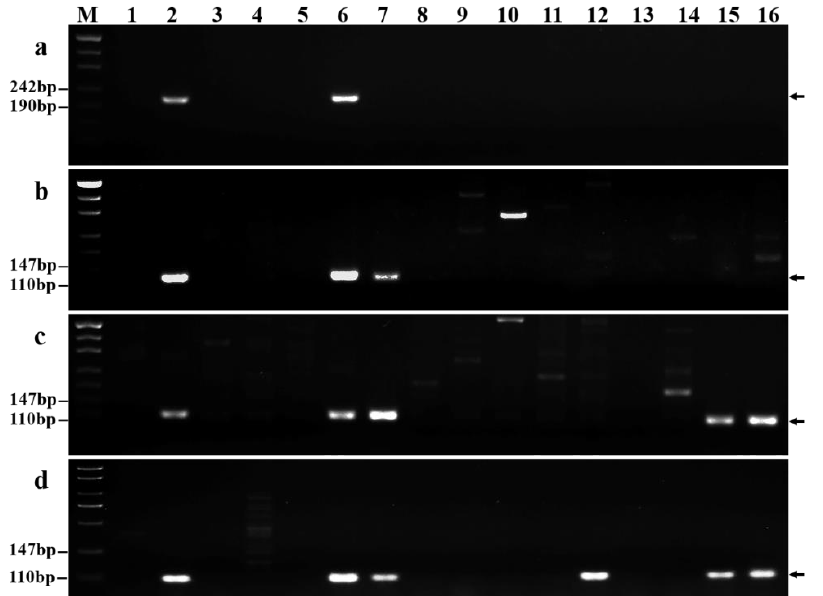
Figure 7. Specificity and stability of P. huashanica 7Ns chromosome-specific markers in other wheat- related species. ( a ) GPH7Ns-155; ( b ) GPH7Ns-300; ( c ) GPH7Ns-523; and ( d ) GPH7Ns-350. (M) Marker (500 bp); (1) CS; (2) 18-1-5 (wheat – P. huashanica 7Ns disomic addition line); (3) T. monococcum ; (4) Ae. speltoides ; (5) Ae. tauschii ; (6) P. huashanica ; (7) P. juncea ; (8) Th. bessarabicum ; (9) Th. elongatum ; (10) D. villosum ; (11) H. bogdanii ; (12) Ag. cristatum ; (13) S. cereale ; (14) Pse. libanotica ; (15) L. multicaulis ; and (16) L. angustus . Arrows show the diagnostic amplification products of P. huashanica